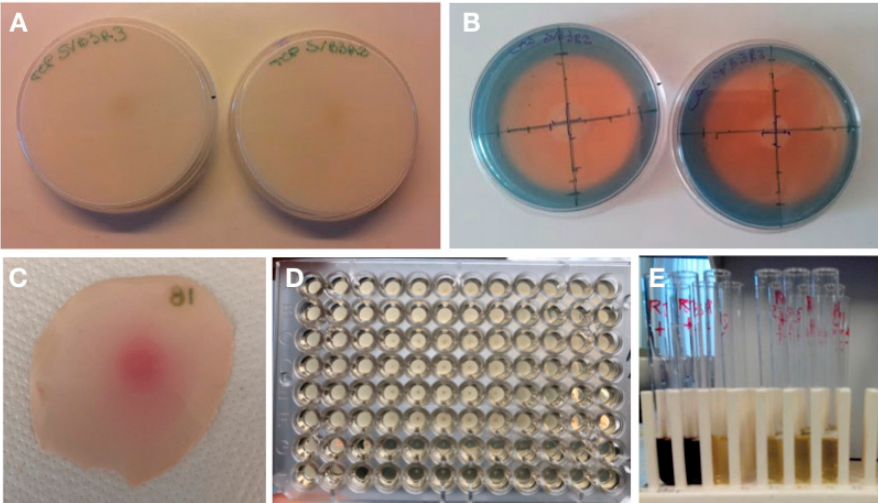
Figure 3. Screening of the physiological traits involved in plant growth promotion. ( A ) Phosphate solubilization on tricalcium phosphate (TCP) medium (bacterial growth indicates phosphate solubilizing activity); ( B ) siderophore synthesis on Chrome Azurol S (CAS) agar (orange halo); ( C ) IAA production (pink halo); ( D ) tolerance to salt stress evaluated as minimal inhibitory concentration (MIC) showing the tolerance of bacterial strains to specific molecules. The well was considered positive when the presence of a bacterial cell pellet was observed; ( E ) 1-aminocyclopropane-1-carboxylate (ACC) deaminase synthesis (brown/black color development).